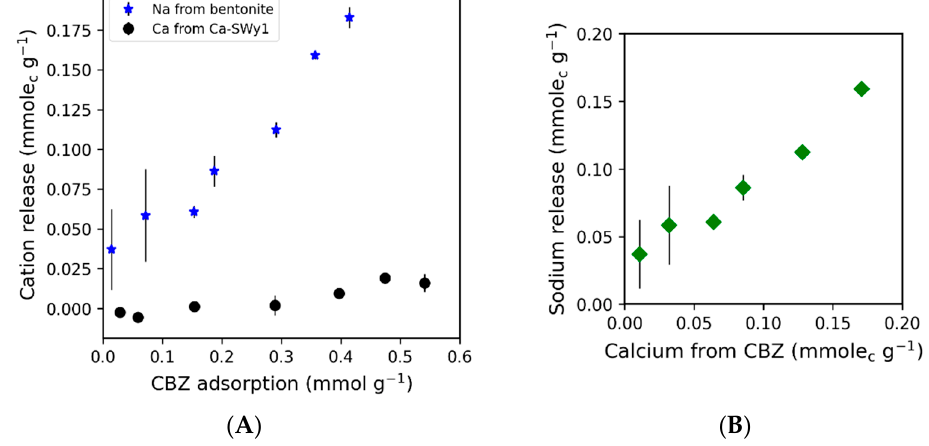
Figure 3. ( A ) Cations released to supernatant from bentonite (blue asterisk) or Ca-SWy1 (black circle) as a function of the adsorbed CBZ. ( B ) Na + measured due to the addition of Ca +2 from CBZ solution (green diamonds).